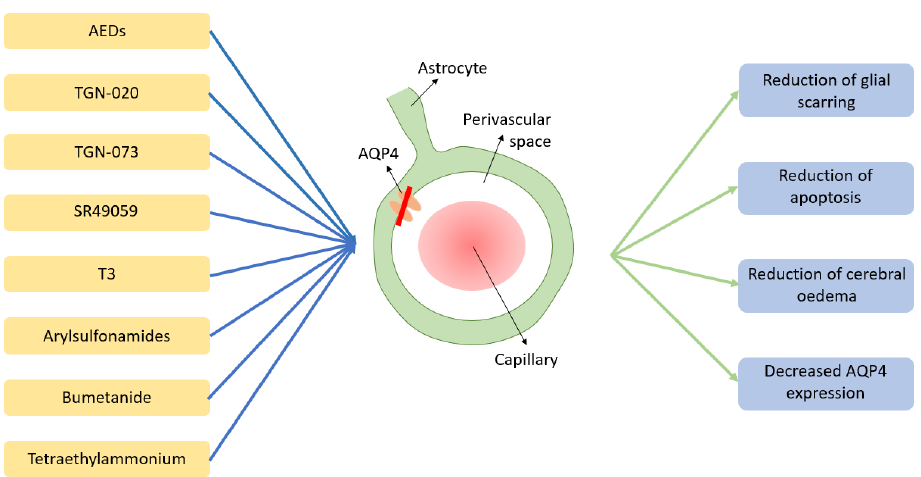
Figure 2. Potential/speculative pharmacological modulators of the glymphatic system and their potential mechanism of action. Pharmacological agents shown in yellow boxes all exert a modulating effect on AQP4, resulting in a net inhibition (red line) of its activity. The blue boxes outline the suggested biological effects of AQP4 modulation as emerged from available literature. Abbreviations: AEDs = anti-epileptic drugs, AQP4 = Aquaporin 4; TGN-20 = 2-(nicotinamide)-1,3,4-thiadiazole, TGN-073 = ( N-(3-benzyloxypyridin-2-yl)-benzene-sulfonamide) , T3 = 3,3 ′ ,5-triiodo- L -thyronine.